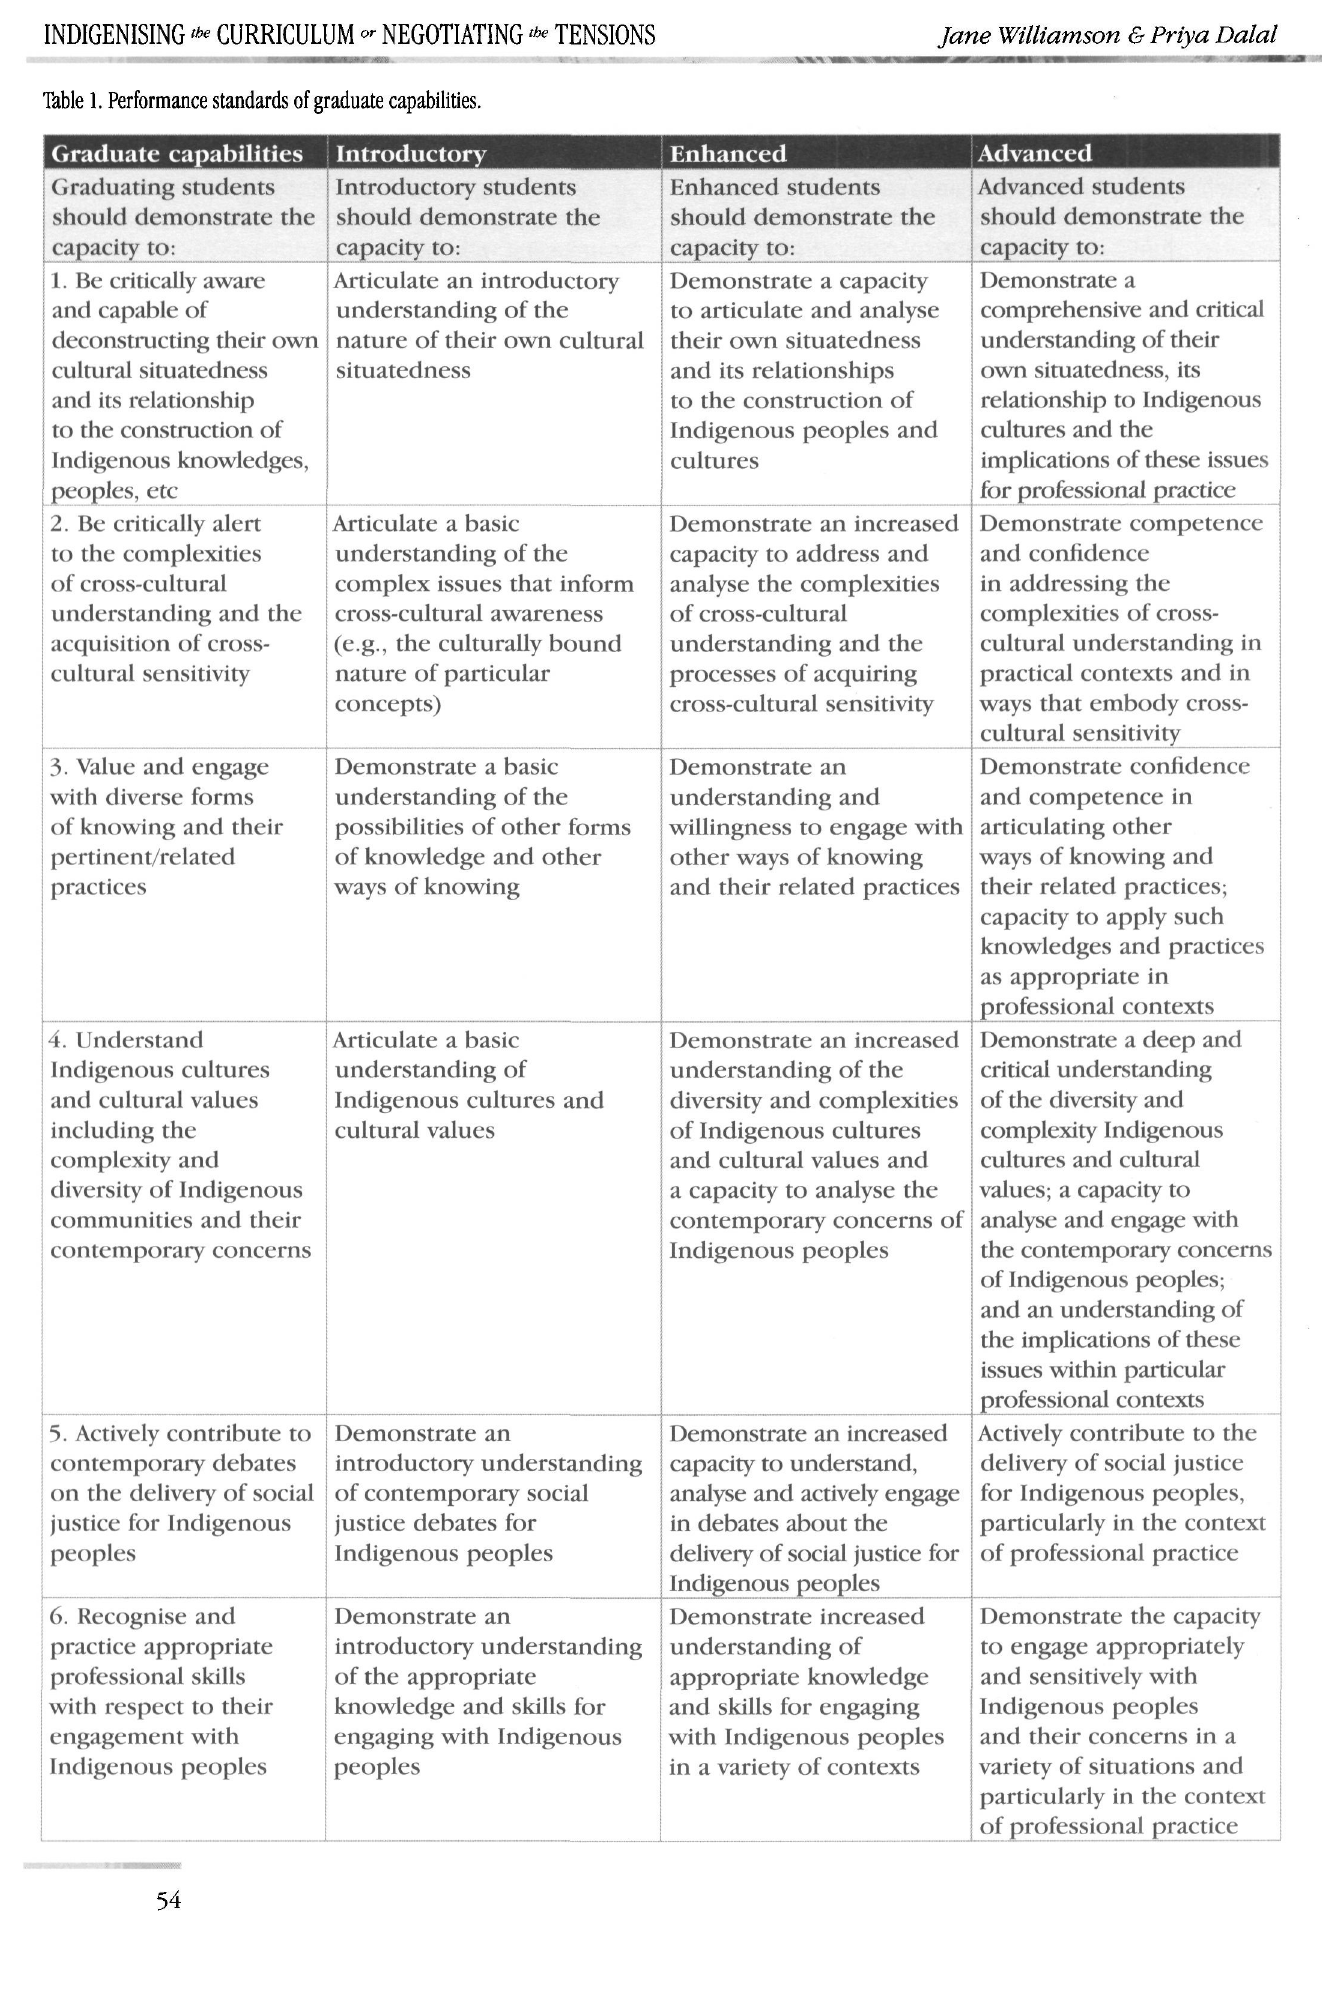
Table 1. Performance standards of graduate